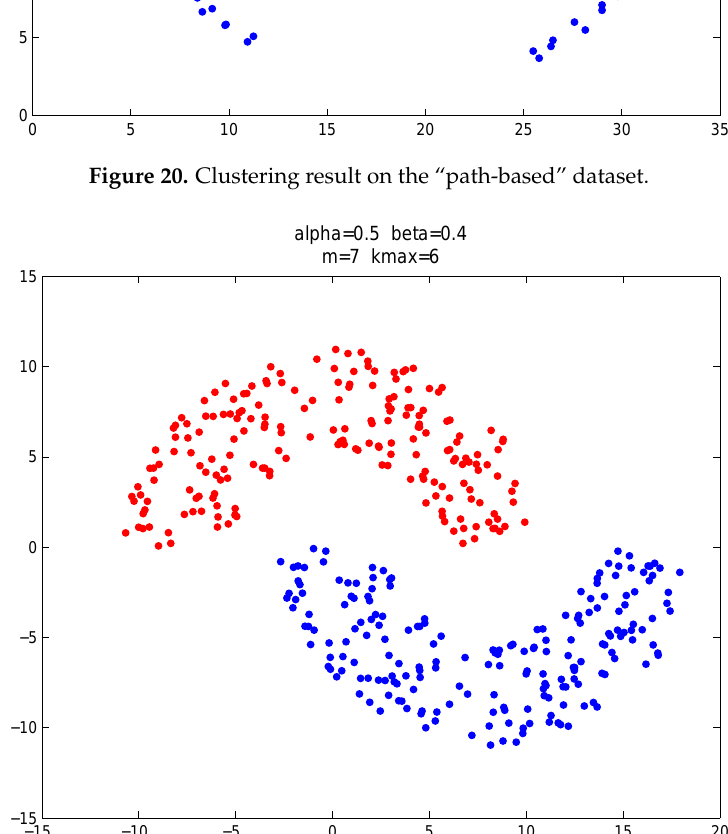
Figure 21. Clustering result on “double-moon”